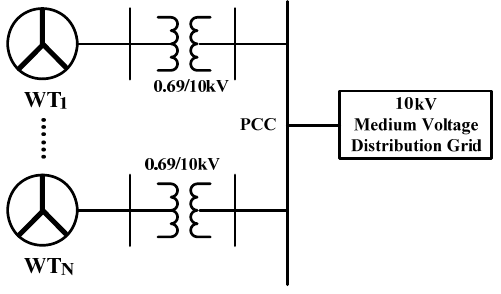
Figure 1. The topological diagram of the small-scale wind farm.